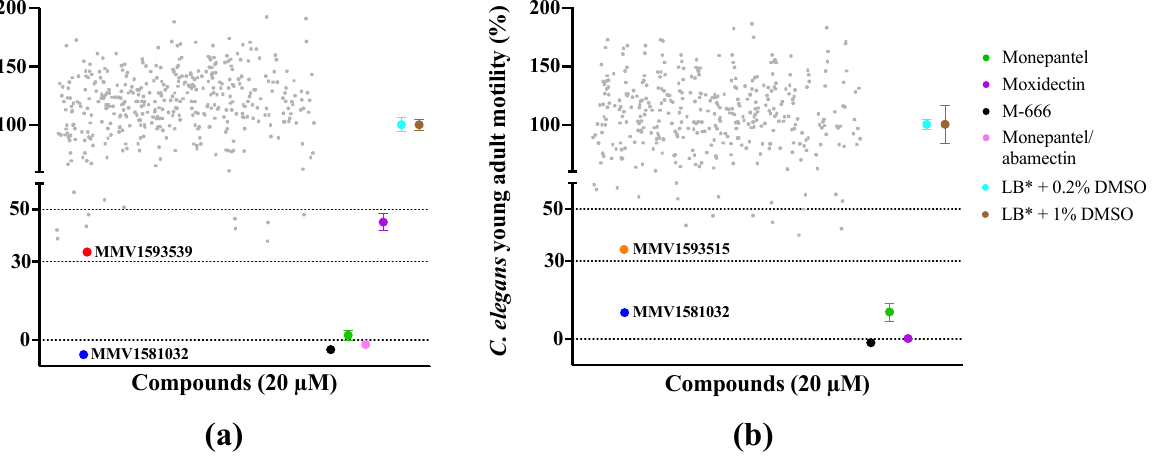
Figure 1. Results of the primary screen of the Medicines for Malaria Venture (MMV) Pandemic Response Box ( n = 400) against ( a ) exsheathed third-stage larvae (xL3s) of Haemonchus contortus and ( b ) young adults of Caenorhabditis elegans with reference to four distinct control compounds (monepantel, moxidectin, M-666 and monepantel/abamectin) and negative (LB* + DMSO only) controls. All test and positive control compounds were tested at 20 μ M. Each grey dot represents an individual test compound. Mean ± standard error of the mean (SEM) indicated for negative and positive control compounds (four data points for each positive control; 24 data points for LB* + 0.2% DMSO; eight data points for LB* + 1% DMSO).